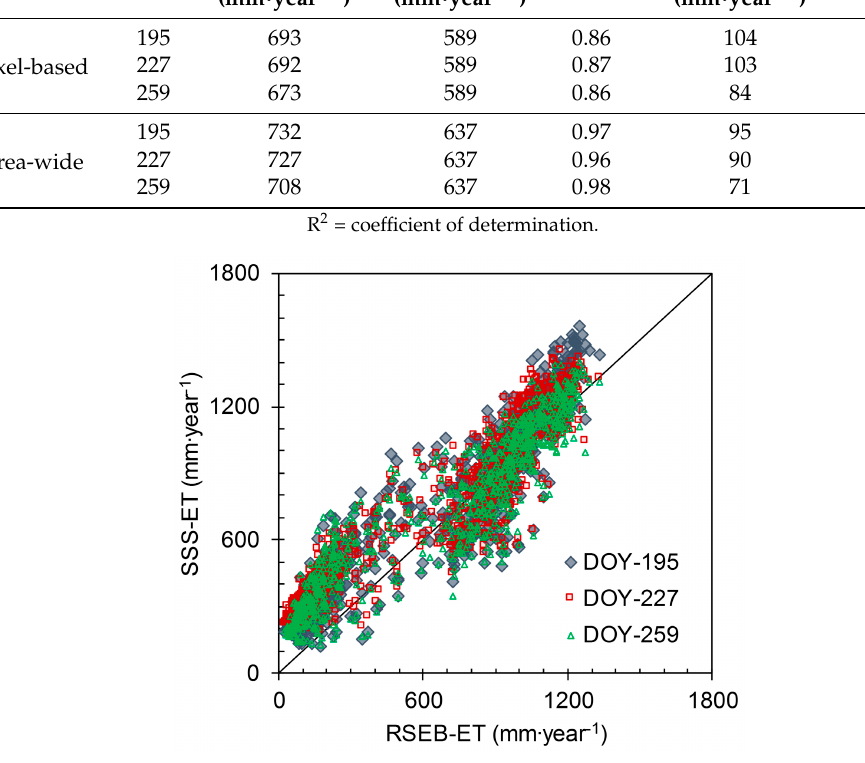
Figure 4. Comparison of annual single-satellite-scene evapotranspiration (SSS-ET) and remotely sensed energy balance evapotranspiration (RSEB-ET) for randomly selected samples within the CNWR. Table 1. Summary of pixel-based and area-wide comparison of SSS-ET and RSEB-ET.